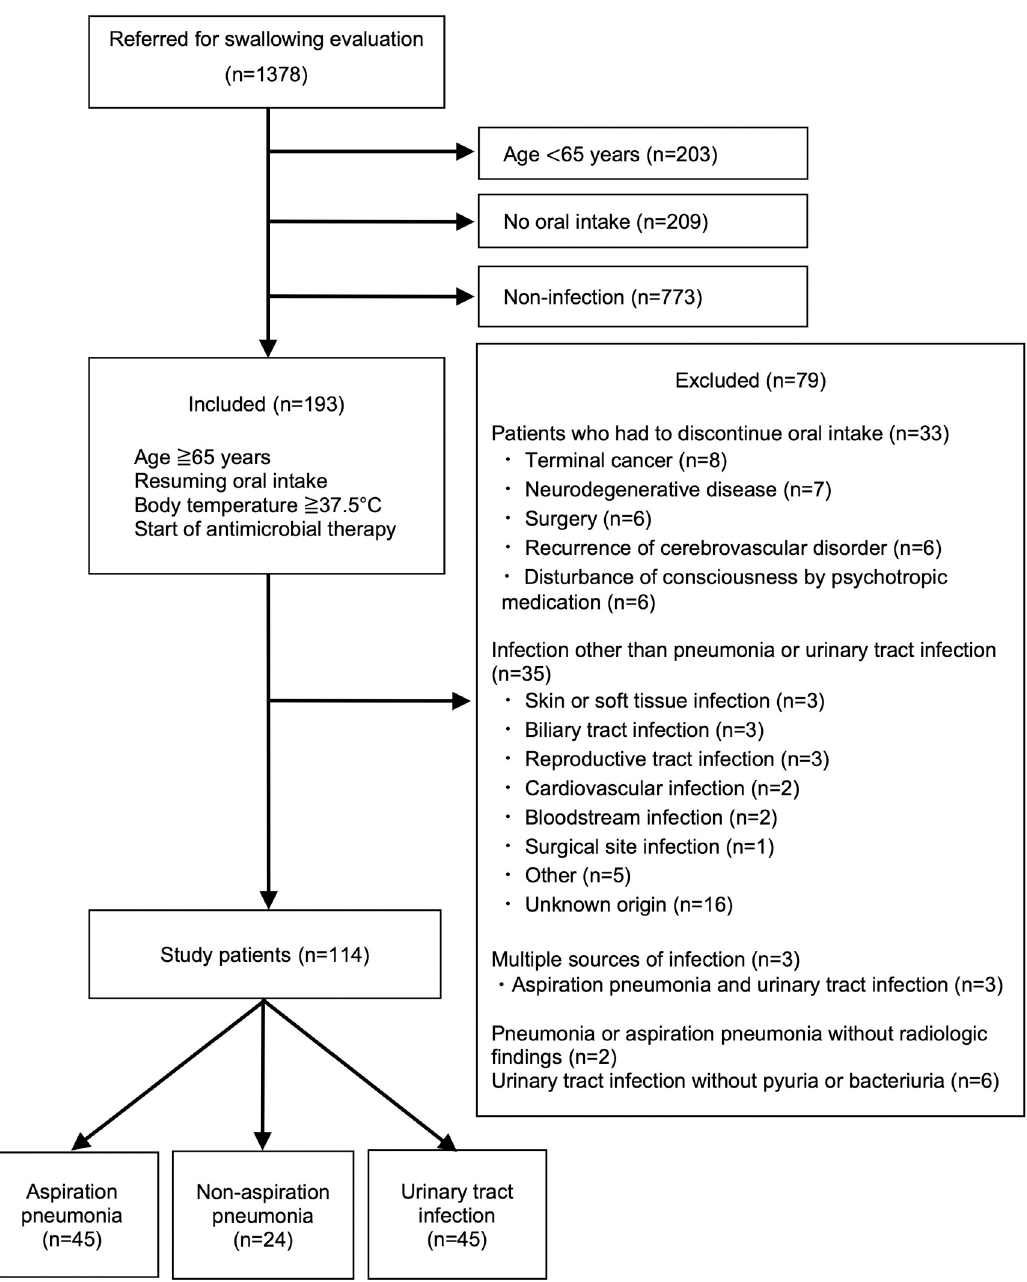
Fig 1. Flow chart showing how patients were selected for enrolment in the